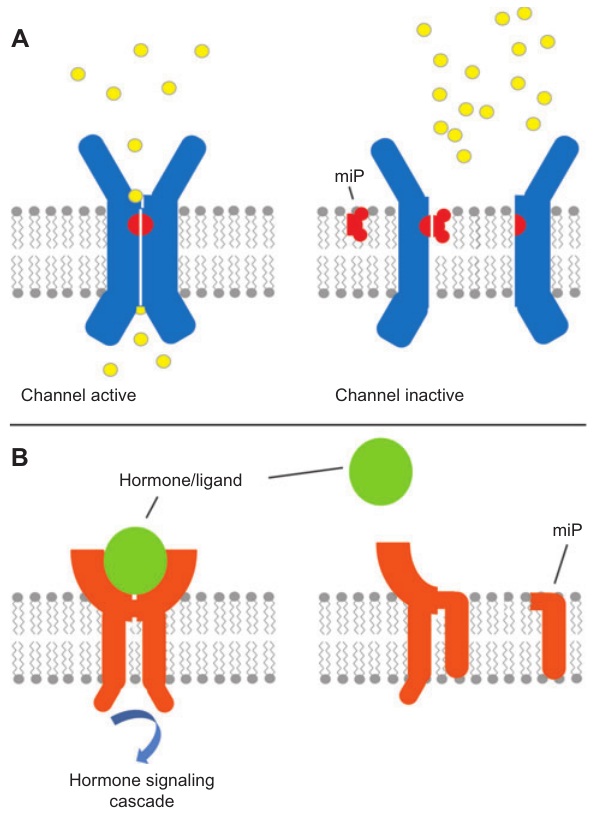
Figure 2 miPs interfering with non-transcription factor proteins. (A) Regulation of ion channel activity. This example shows a protein dimer forming a functional pore. Dimerization is mediated through a PPI domain (red). miPs containing the PPI domain can sequester the proteins into non-functional heterodimeric complexes, perturb- ing pore formation and channel function. (B) Potential regulation of membrane-bound hormone receptors. MiP proteins form non- functional heteromers thereby blocking hormone